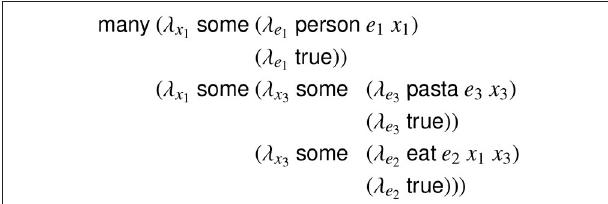
FIGURE 2 | Lambda calculus expression for the propositional content of the sentence. Many people eat pasta, using generalized quantifiers over discourse entities and